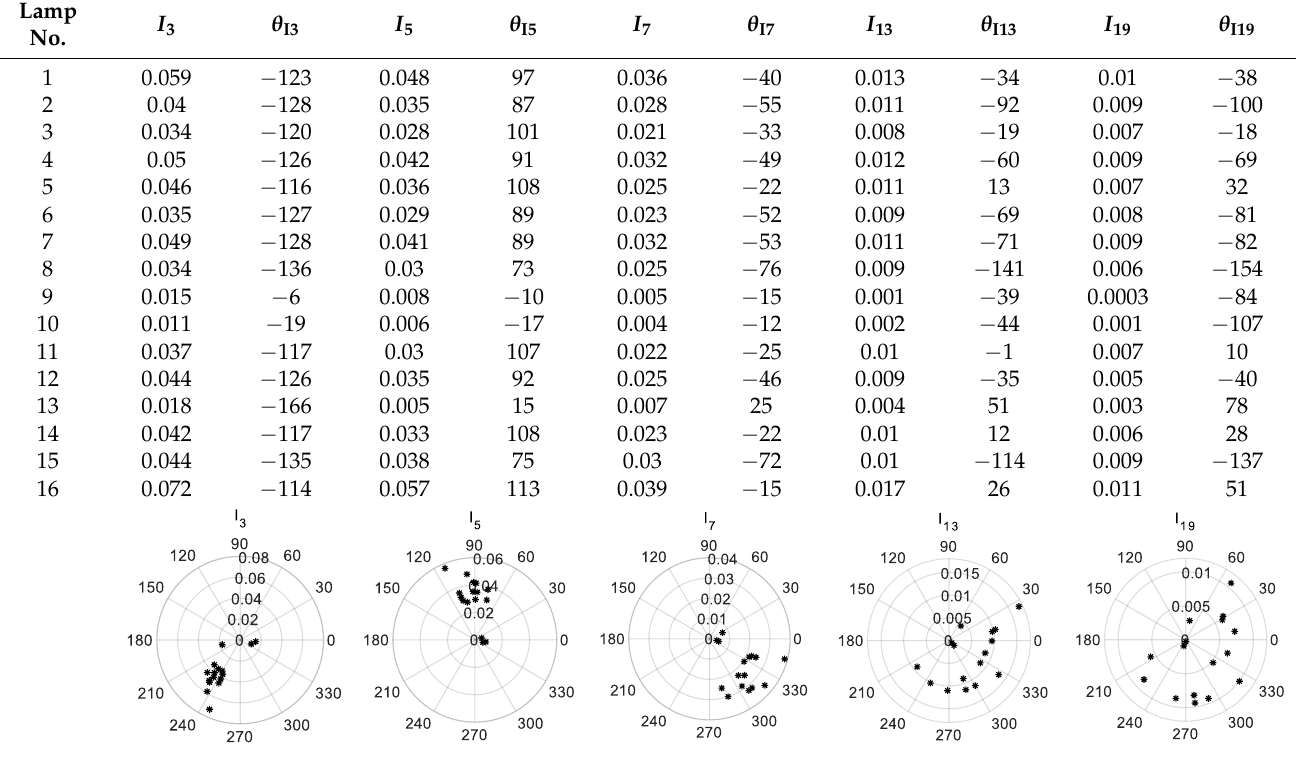
Table 2. Measured harmonics’ current characteristics for individual lamps.